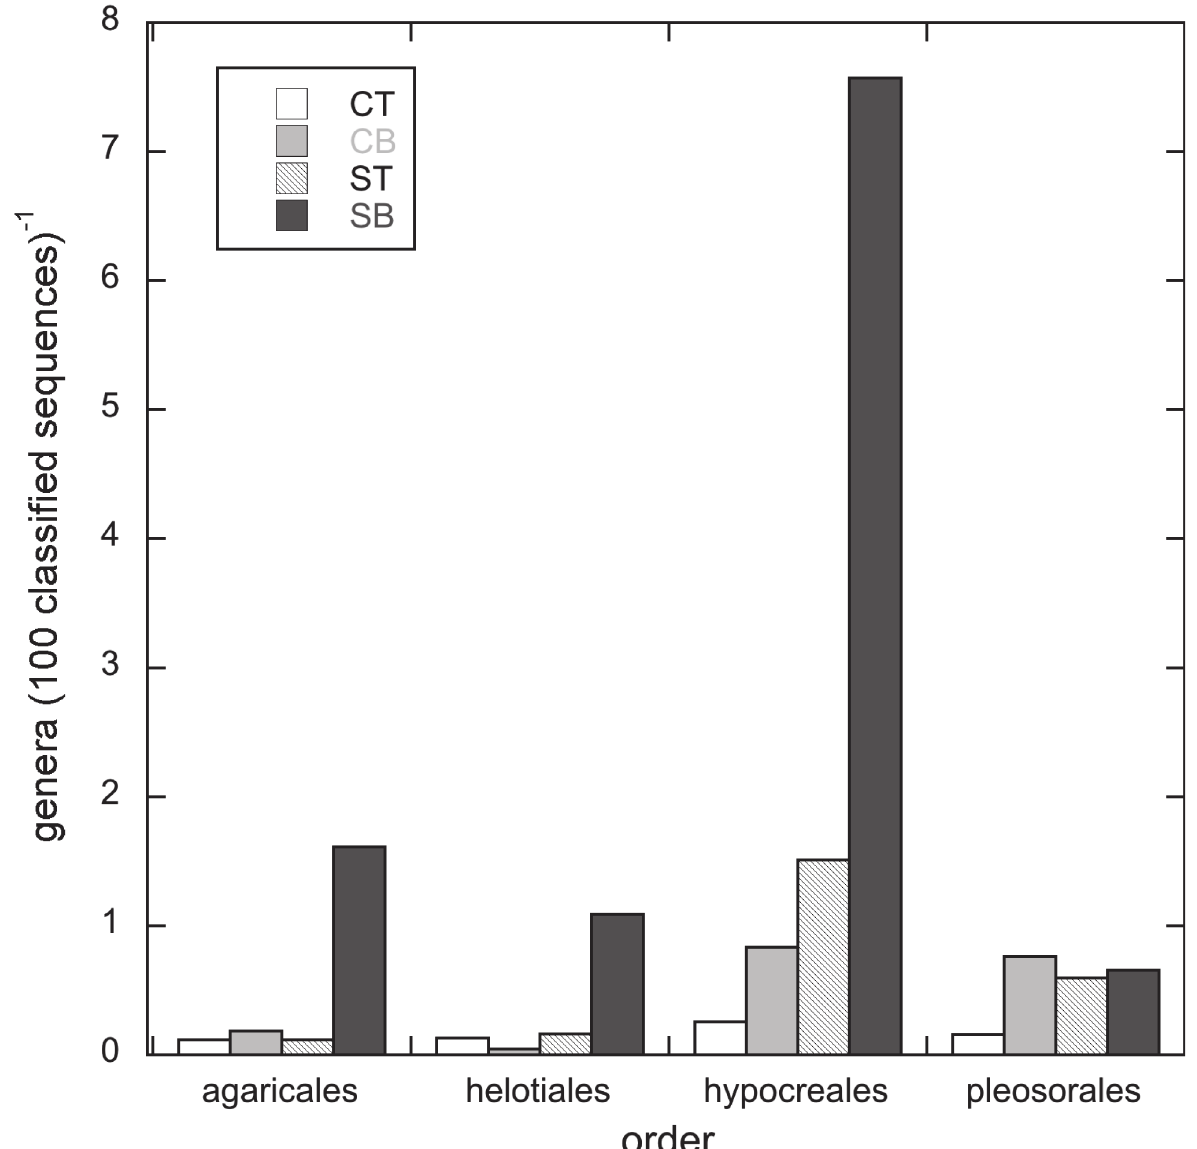
Figure 5. The number of genera recovered (100 sequences classified) -1 in composite libraries for CT, ST, CB and SB libraries. Composite libraries for each of the four soil intervals include the libraries generated from the six field replicates. Sequences represented were classified at the genus level with (cid:4) 80% confidence in the Ribosomal Database Project Classifier. Soil intervals and sequence libraries from them are designated as CT (cheatgrass 0 – 4 cm), CB (cheatgrass 4 – 8 cm), ST (sagebrush 0 – 4 cm) and SB (sagebrush 4 – 8 cm).